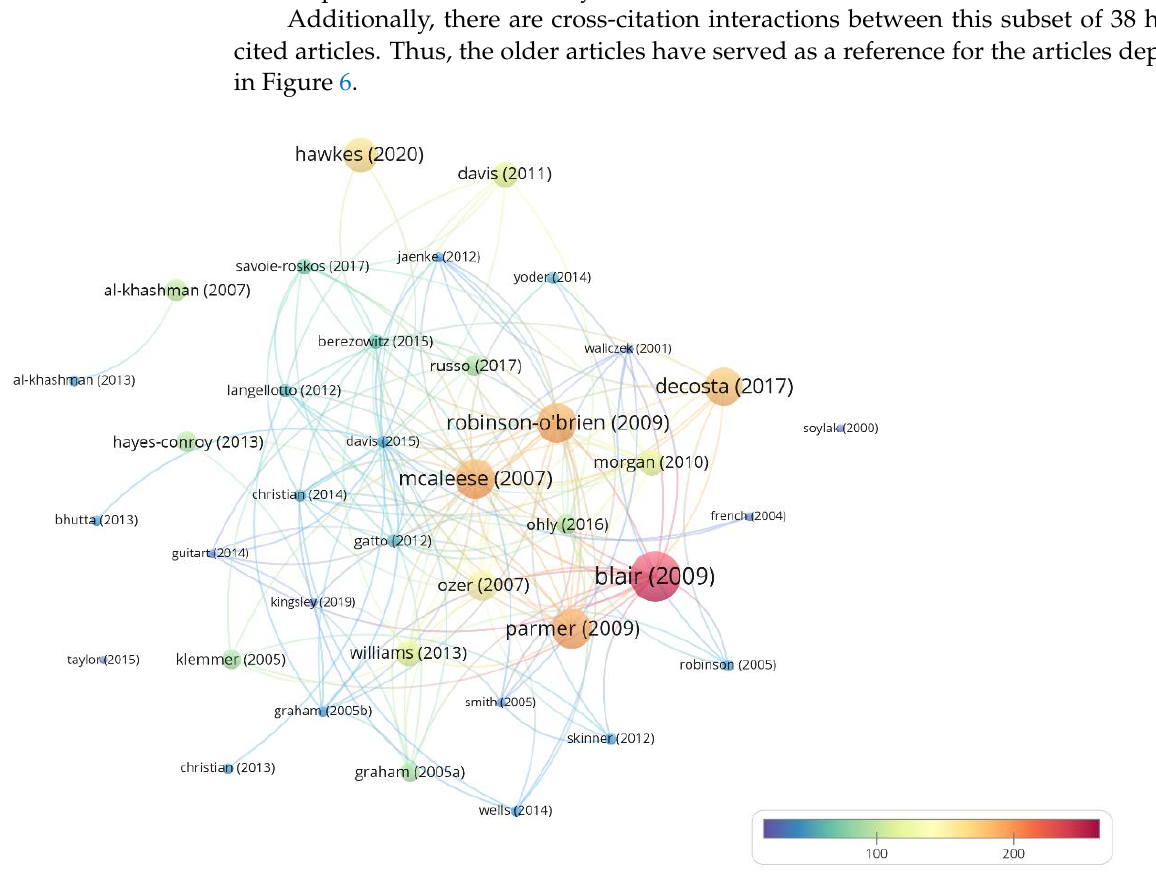
Figure 6. Cross-citation article graph; color nodes indicate the citation level.